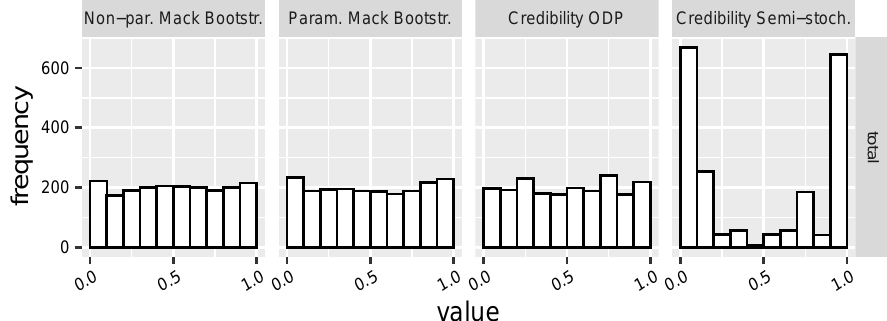
Figure 6. PIT histograms from the log-normal data. Non−par. Mack Bootstr. Param. Mack Bootstr.